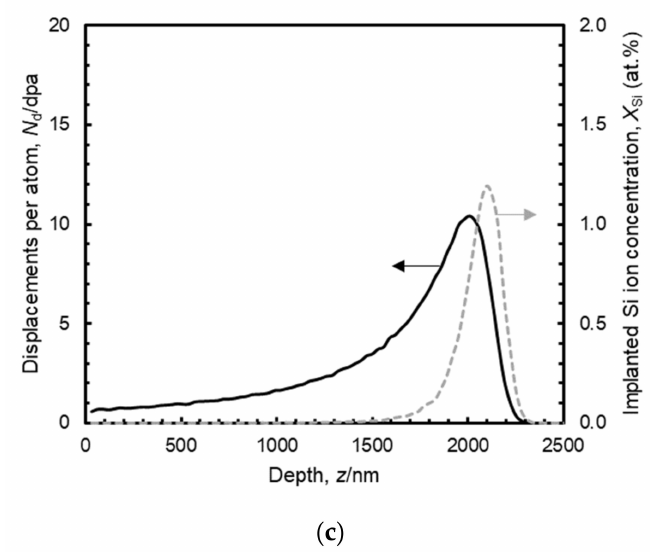
Figure 2. Number of displacements per atom and implanted Si ion concentration in ( a ) pure Ti, ( b ) pure Cr and ( c ) SiC after irradiation with 5.1 MeV Si 2+ ions to a fluence of 2.85 × 10 20 ions/m 2 calculated by